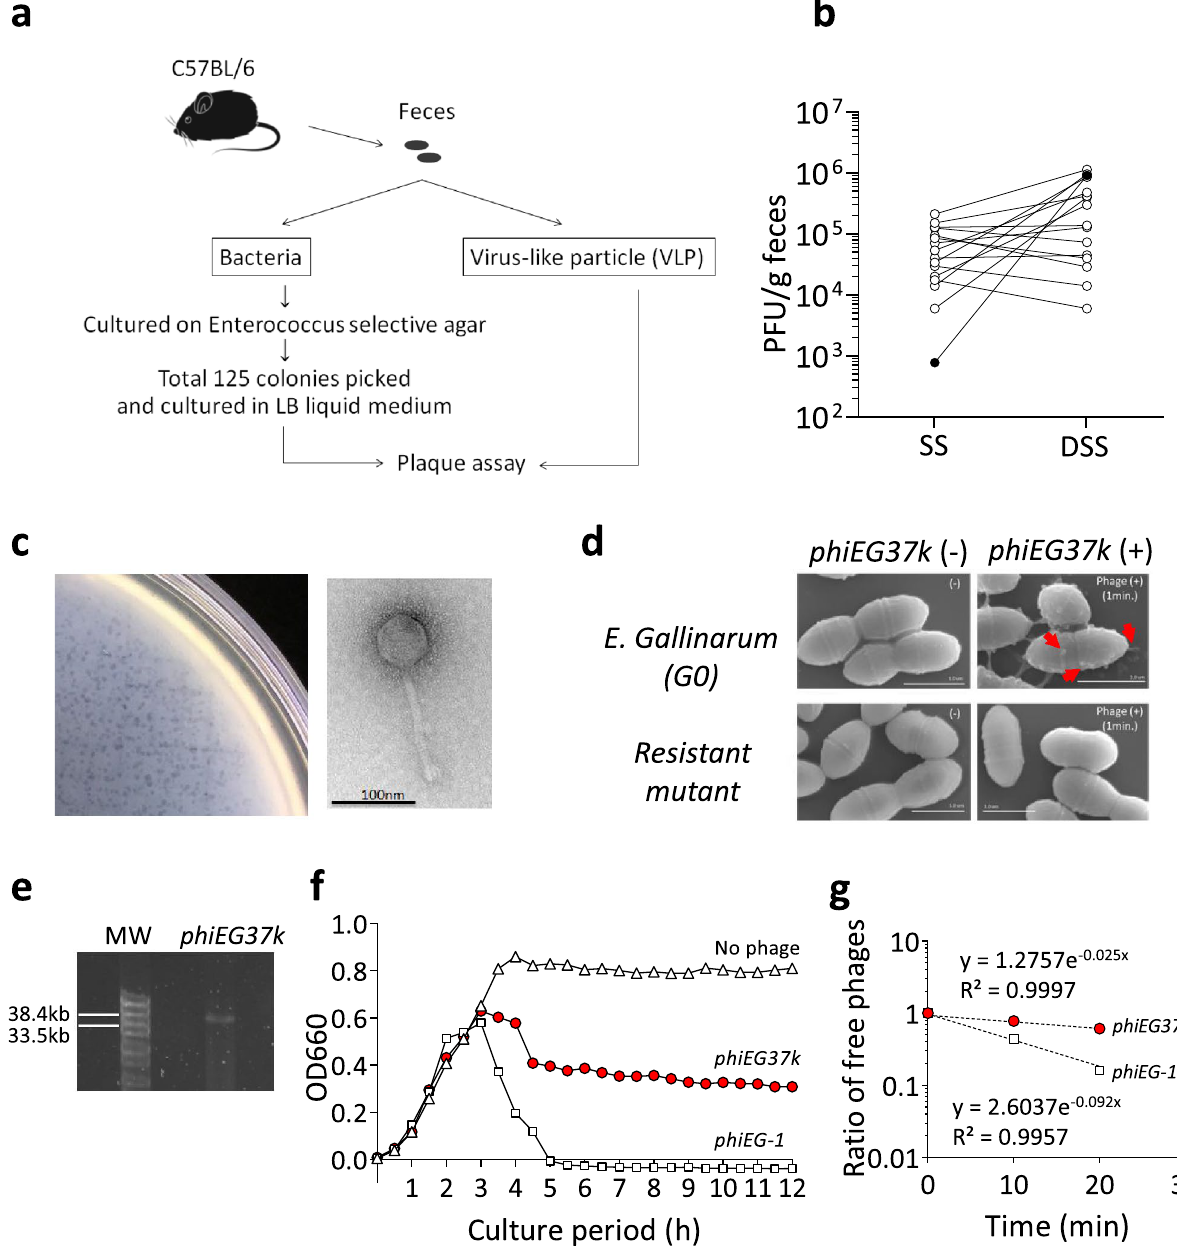
Figure 1. Identification of novel Enterococcus phages associated with colitis. Colitis-associated Enterococcus phages were identified by screening feces from C57BL/6 mice using a plaque assay. ( a ) Schema of screening for gut Enterococcus phages from C57BL/6 mice in steady state. ( b ) Plaque-forming unit (PFU) of phages associated with 16 individual Enterococcal bacterial clones was measured in steady state (SS) and during dextran sulfate (DSS)-induced colitis. The feces during colitis was taken on day 10, which is 3 days after the replacement of DSS with normal drinking water. The PFUs of the phage associated with Enterococcus strain G0 ( phiEG37k ) are indicated with black circles. ( c ) Plaques formed by phiEG37k phage (left panel) and the transmission electron microscopic image of the phage (right panel). ( d ) Scanning electron microscopic images of interaction of phiEG37k with host E. gallinarum or a resistant strain derived of the original strain. phiEG37k phages attached to the E. gallinarum are indicated by red arrows. Scale bars indicate 1 µm. ( e ) Electrophoresis of phiEG37k genome DNA on 1% agarose gel. MW; molecular weight marker ( f ) Lysis curves of E. gallinarum co-cultured with phiEG37k or phiEG-1 , or without phage. The OD660 was measured on indicated time points. ( g ) Adsorption assay of phiEG37k and phi